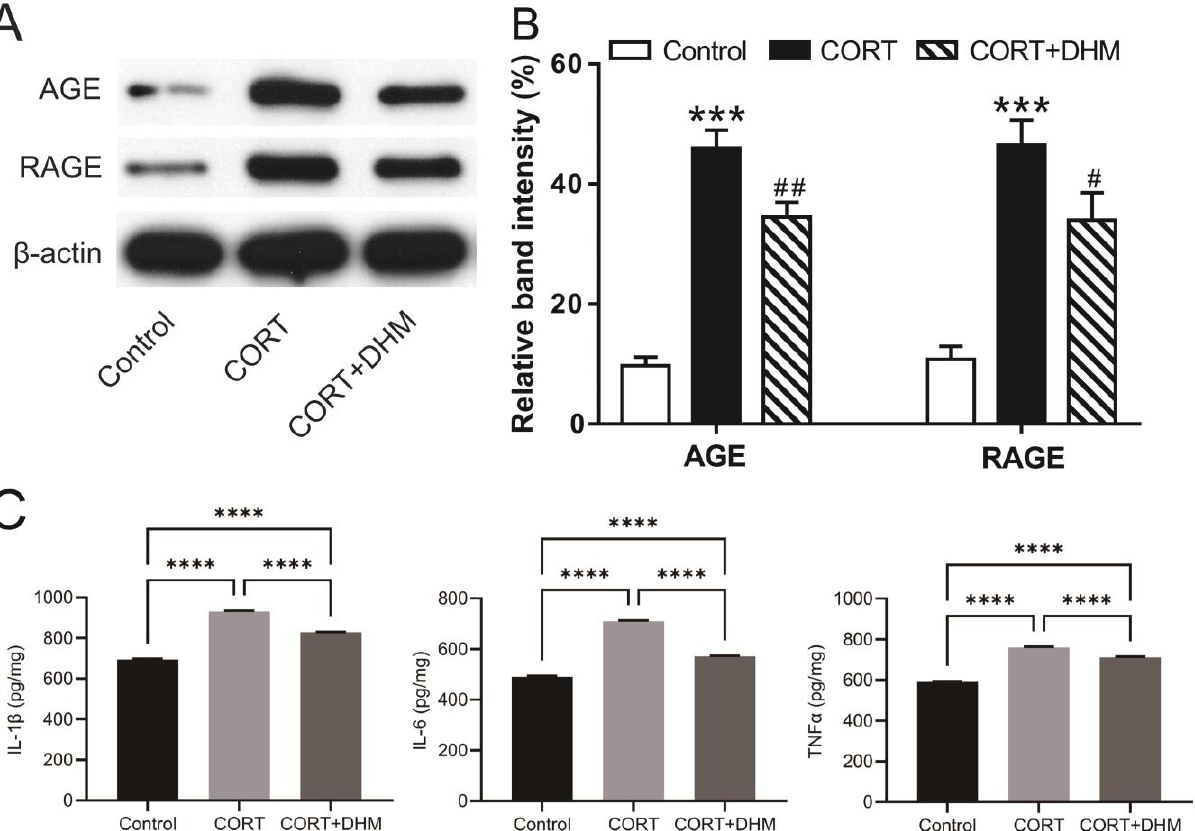
Figure 7. Inhibition of AGE-RAGE-mediated inflammation by DHM in the hippocampus of CORT- treated mice. ( A ) Representative immunoblots of hippocampal AGE, RAGE. ( B ) Quantification of AGE, RAGE by normalizing to β -actin. Data are expressed as mean ± SEM (n = 4 mice/group). *** p < 0.001, vs. the control group; # p < 0.05, ## p < 0.01, vs. the CORT group. ( C ) Levels of proinflammatory cytokines, IL- 1β, IL - 6 and TNFα detected by ELISA. Data are expressed as mean ± SEM (n = 5 mice/group). **** p < 0.0001. CORT, corticosterone; DHM, dihydromyricetin.